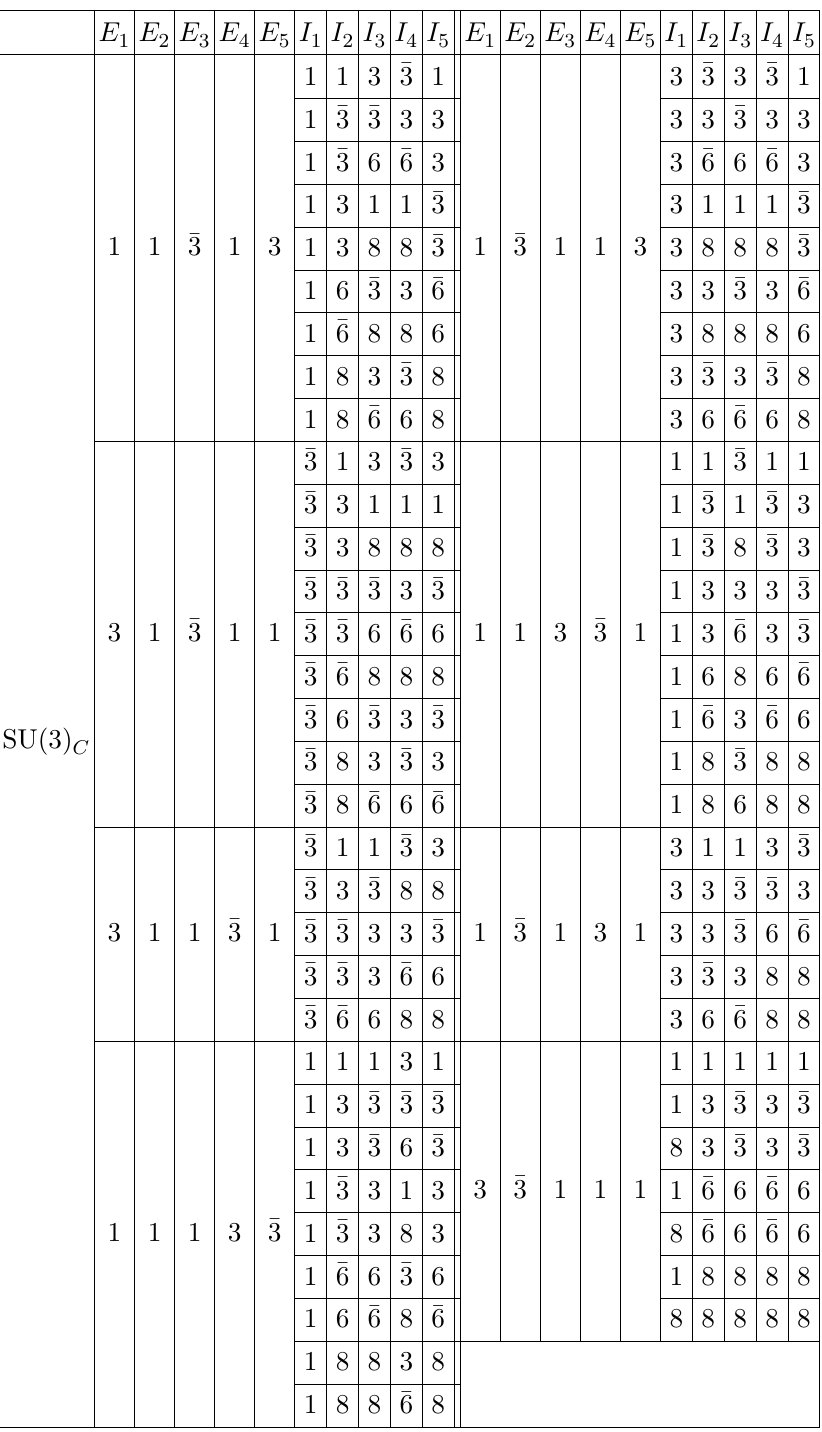
Table 7. The independent SU(2) and SU(3) quantum number assignments for the topology L C NL-1-2, where E and I denote the external fields and internal fields respectively. Other assignments i i are related to these in the table through permutations of external and internal